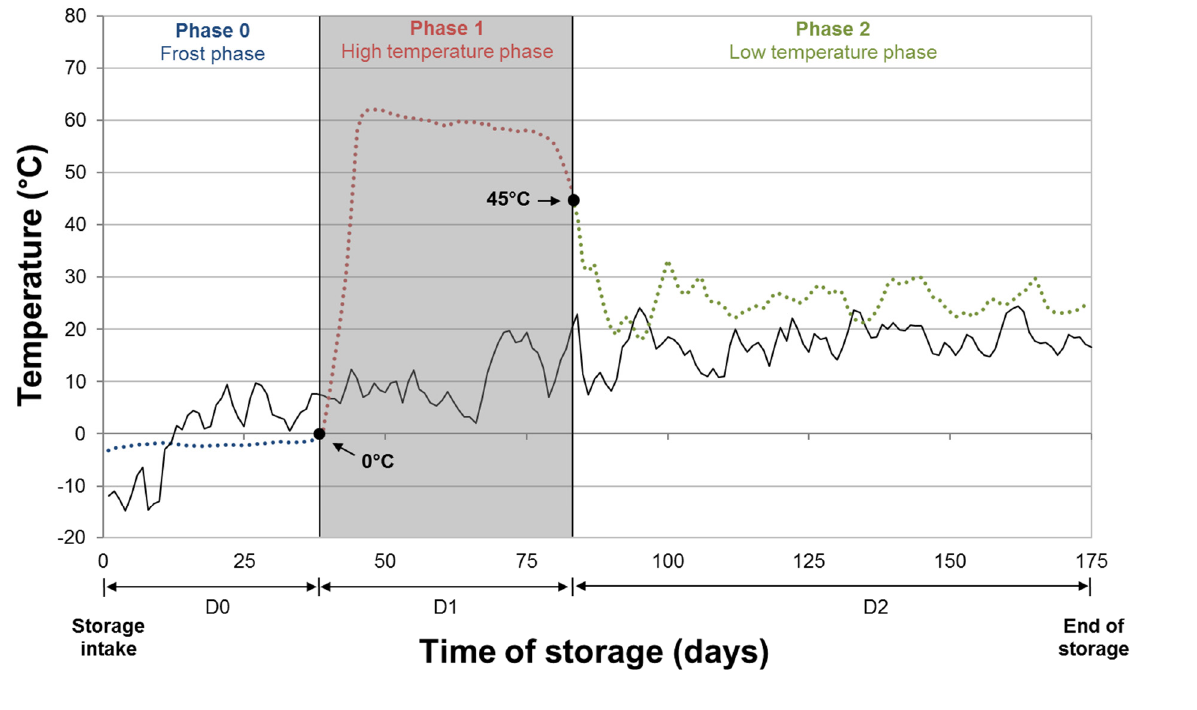
Figure 1. Typical temperature phases of a storage pile of poplar chips harvested in winter, set outdoors in Central Europe. (Modified from Idler et al. [19]).